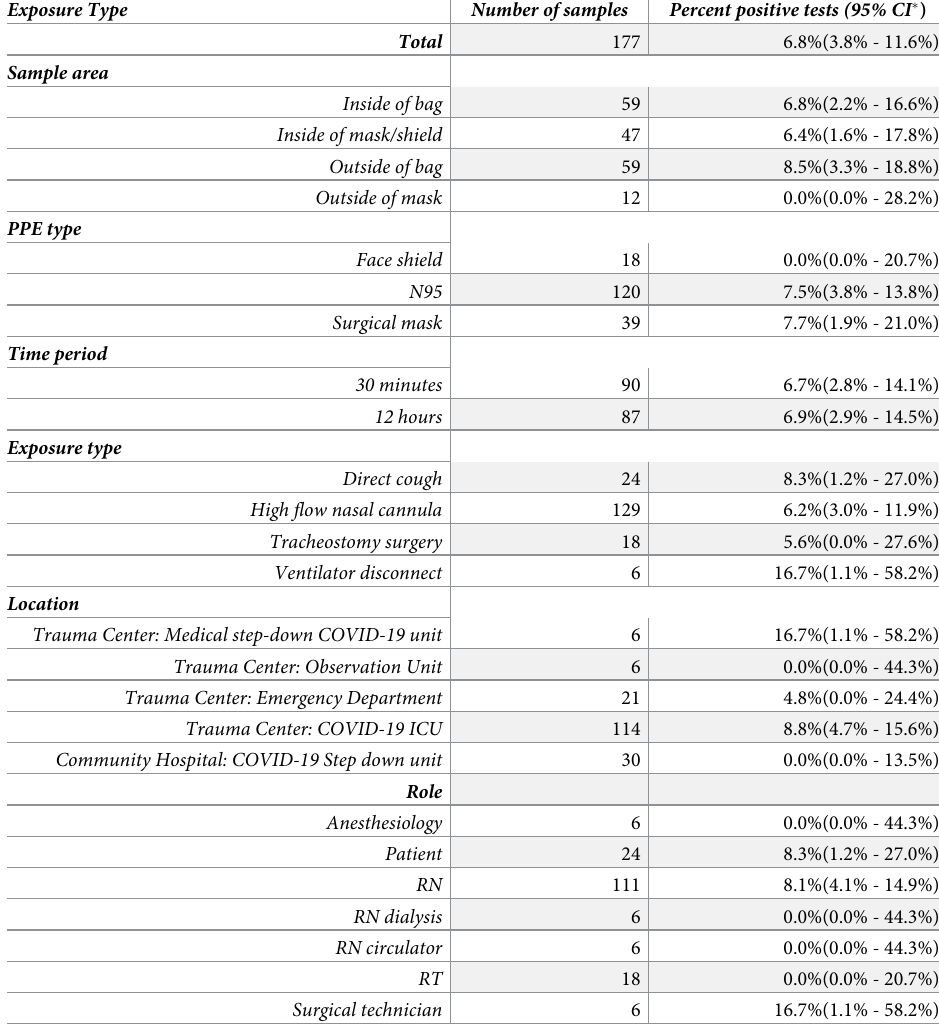
Table 2. Proportion of positive